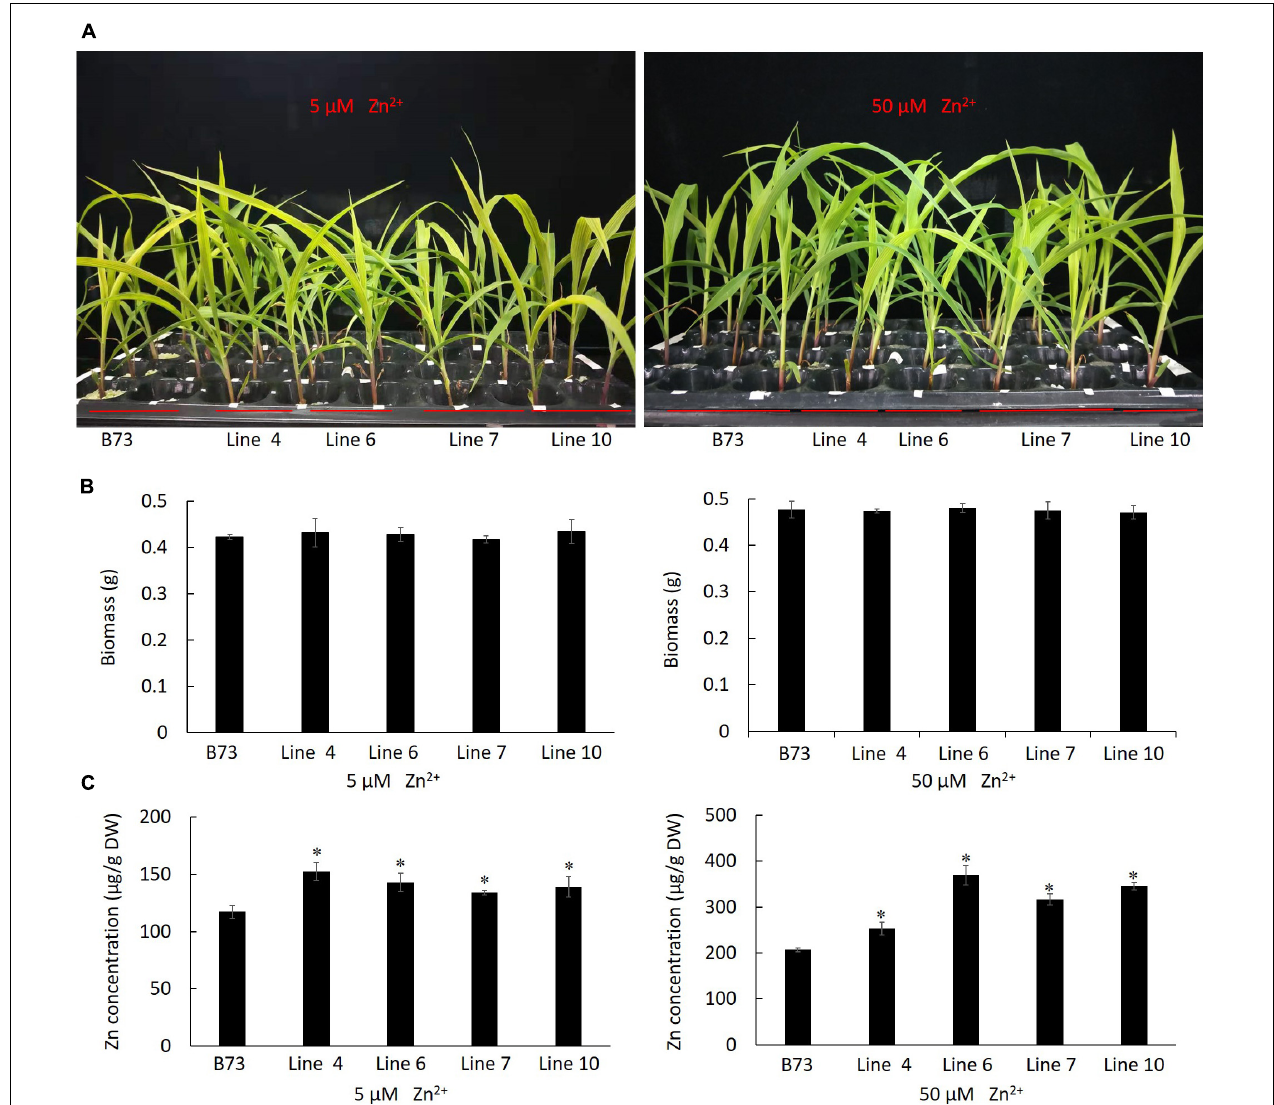
FIGURE 4 | Phenotype of transgenic maize under ZnSO 4 treatment. (A) Phenotype. (B) Biomass. (C) Zn 2 + content. At three-leaf stage, the seedlings of each line were grouped into three replicates, treated with 5 and 50 µ M ZnSO 4 for 3 weeks, then photographed and dried at 60 ◦ C for 72 h, and weighed for biomass and used to measure Zn 2 + content. The biomass of three seedlings of every line was shown. B73, the untransformed control. Line 4, 6, 7, and 10 are homozygous T 3 lines. ∗ p < 0.05.